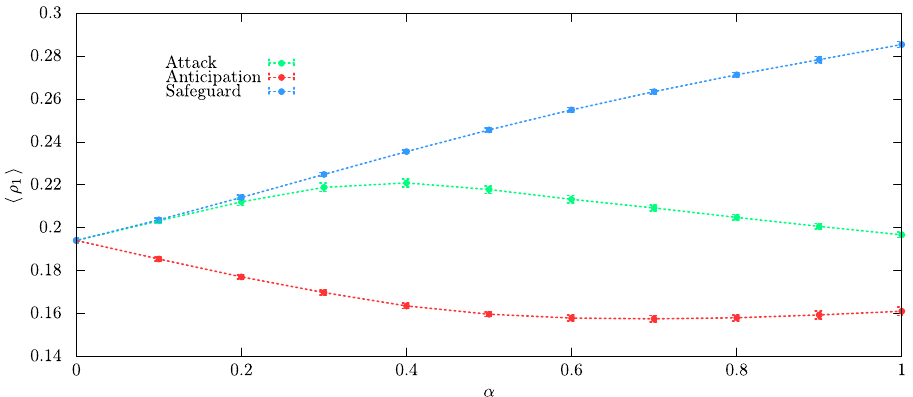
Figure 7. Mean density of species 1 in terms of the conditioning factor α . The green, red, and blue dashed lines show the results for the cases of individuals of species 1 moving according to Attack, Anticipation, and Safeguard tactics, respectively. The error bars show the standard deviation. The results were obtained using R = 3 and s = r = m = 1 / 3 .